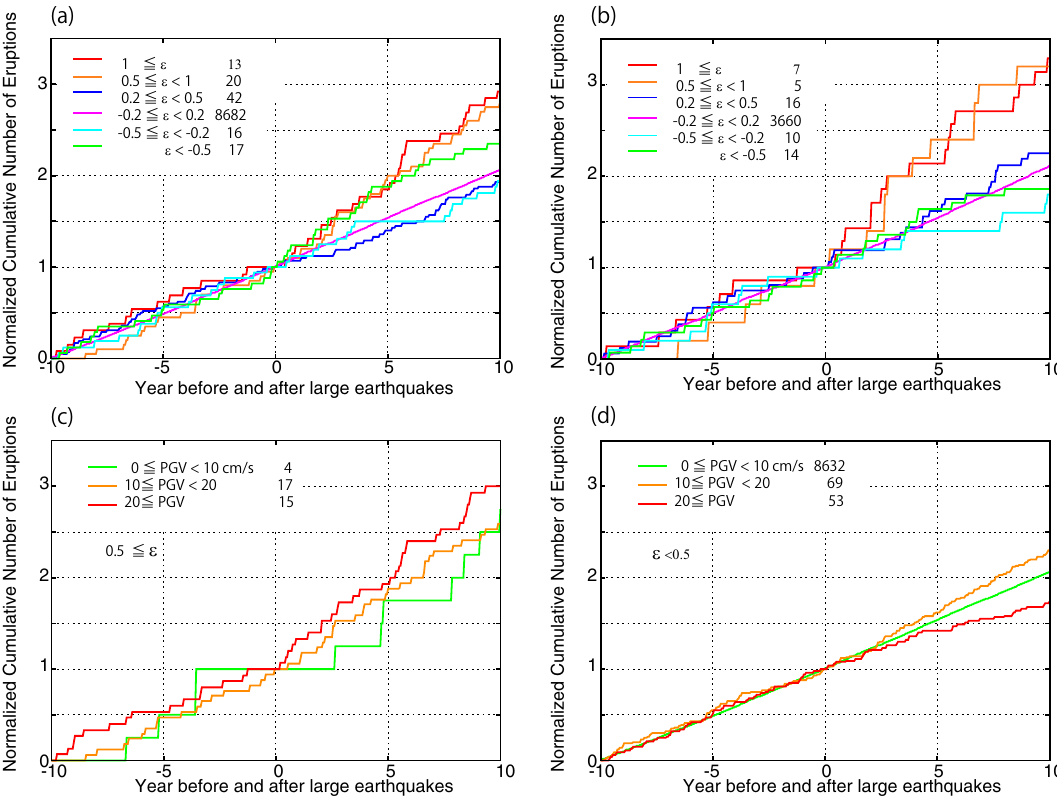
Figure 2. Cumulative number of volcanic eruptions before and after large earthquakes for various static strains and PGVs normalized by the number at 0 years. ( a ) Distributions for various strains under no PGV constraints for all volcano data. ( b ) Same as ( a ) but for only those volcanoes that erupted fewer than 10 times in the past 55 years. ( c ) Distributions for various PGVs for static dilatational strain of at least 0.5 µ. ( d ) Distributions for various PGVs under static strain of less than 0.5 µ . The numbers in the legends are the cumulative numbers of eruptions at 0 years for each strain and PGV